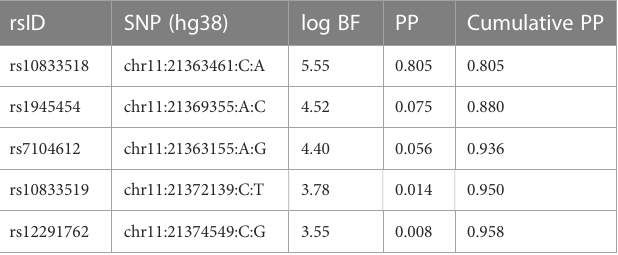
FIGURE 1 GWAS of type 1 diabetes age-of-onset reveals a novel locus. (A) Manhattan plot of genome-wide association statistics. The x-axis displays the autosomal genome coordinate from chromosome 1 to 22. The y-axis is the negative logarithm of the P value for association of each SNP with the age of onset in meta-analysis. The signal on chromosome 6 originates from the human leukocyte antigen locus. A novel signal in an intron of the NELL1 gene on chromosome 11 reaches genome-wide signi fi cance. (B) Q-Q plot of association P values. (C) Bar plot with mean and standard deviation of the age of onset for each genotype of rs10833518 in meta-analysis, showing a statistically-signi fi cant average age of diagnosis of one year earlier for homozygotes ( P = 1.54 × 10 − 9 , Wald test).